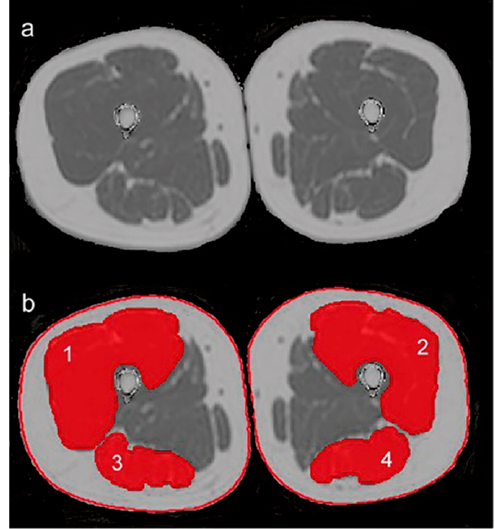
Figure 1. Chemical shift encoding-based water-fat magnetic resonance imaging (MRI) and placement of regions of interest (ROIs). ( a ) Representative proton density fat fraction (PDFF) map. ( b ) PDFF map with superimposition of manually segmented muscle compartments defined as ROIs: (1) right quadriceps muscle, (2) left quadriceps muscle, (3) right ischiocrural muscles, and (4) left ischiocrural muscles. The red lines around the thigh represent the segmentation of the entire thigh contour. Reused from [22] under Creative Commons license.